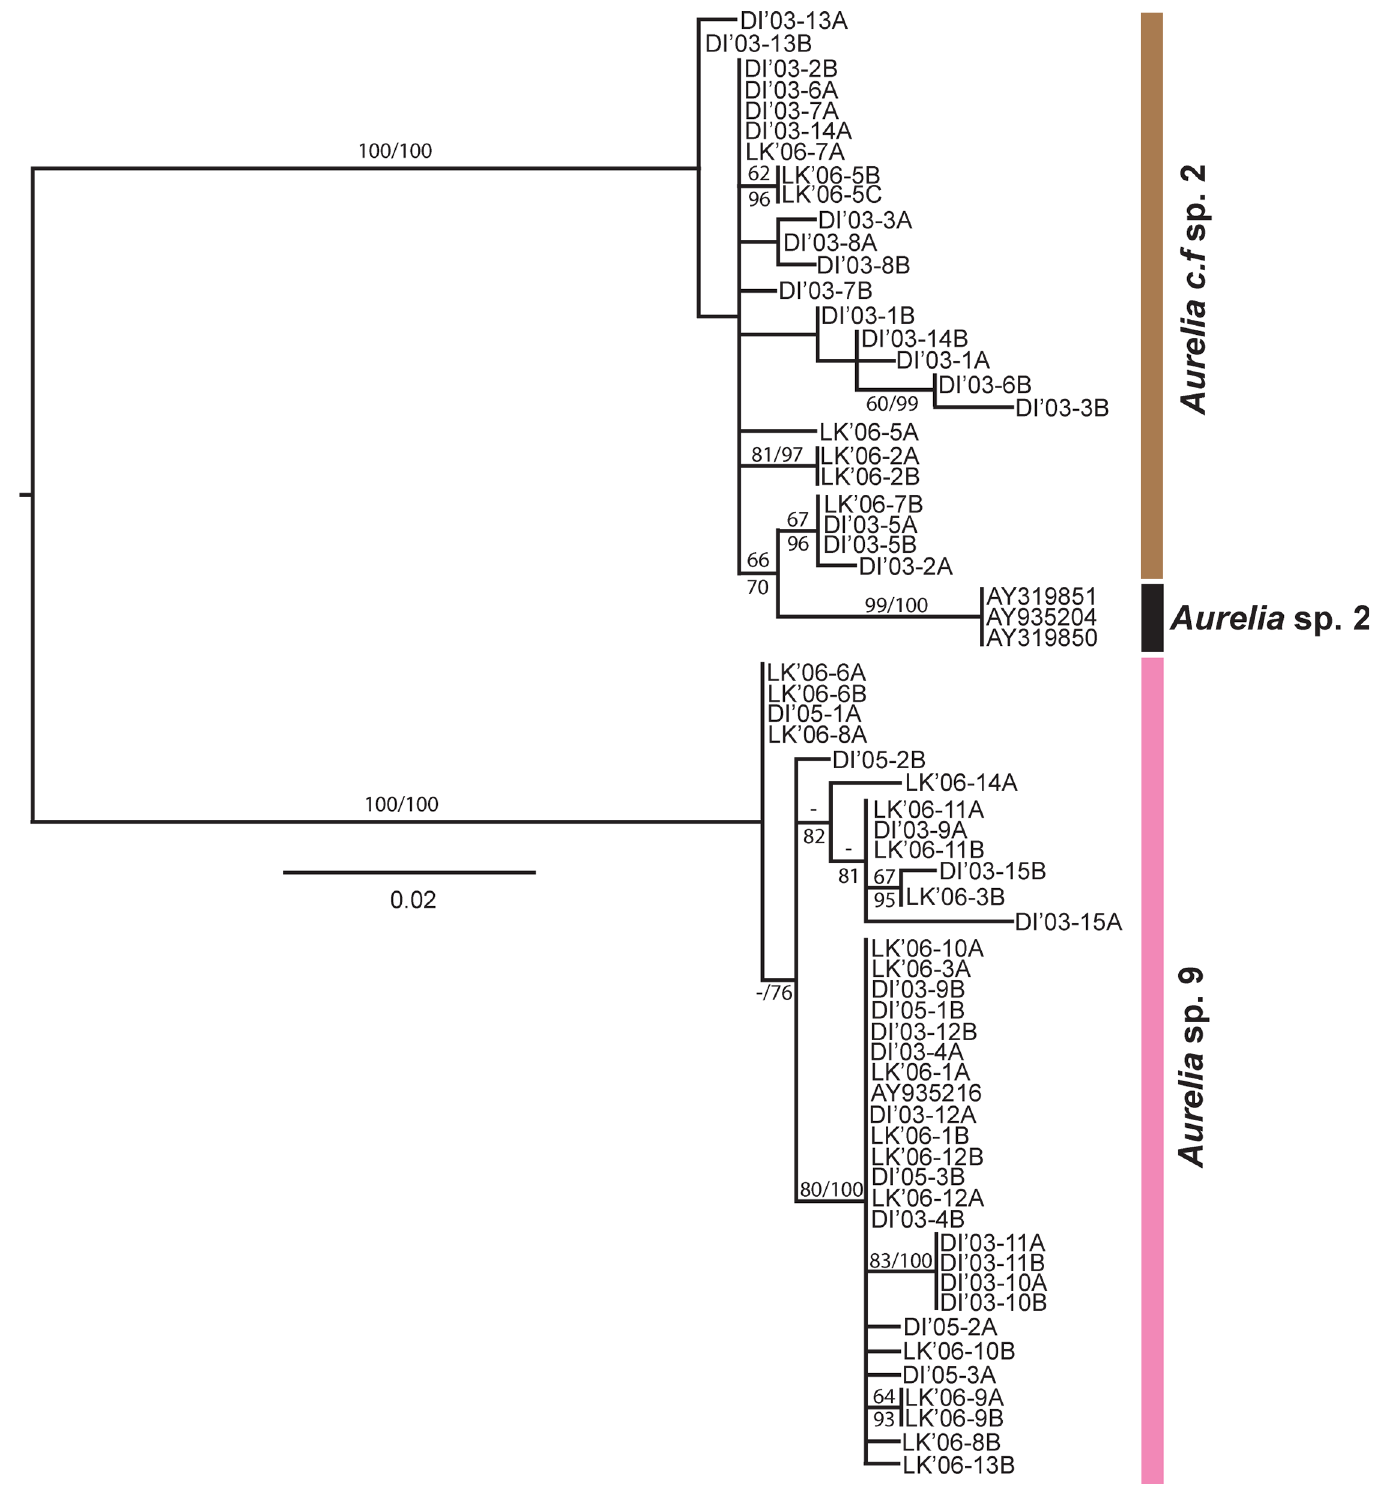
Fig 5. Phylogeny of Aurelia in the Gulf of Mexico based on ITS-1 . Note Aurelia c.f. sp. 2 (based on mitochondrial COI ) is grouped within the Aurelia sp. 2 clade. The tree was mid-rooted. Bootstrap values higher than 50% are shown (maximum likelihood, 1,000 realizations). Sequences obtained in this study are DI (Dauphin Island, AL) and LK (Long Key, FL). The other sequences were obtained from GenBank (see S1 Table).